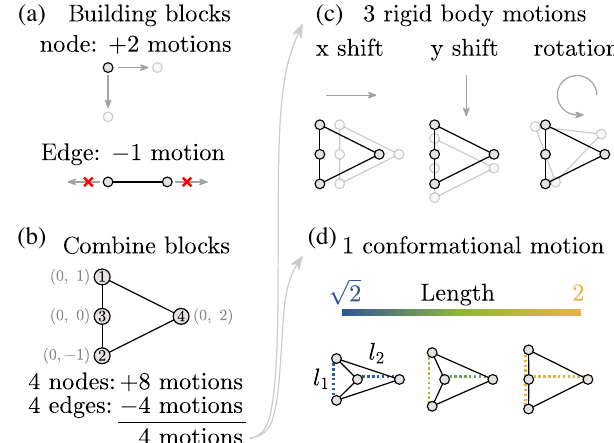
FIG. 1. Constraints and conformational motions. (a) Schematic of a node and an edge embedded in two dimensions, where a node adds two motions (one in each dimension), and an edge removes the one motion that changes its length. (b) Network of four nodes and four edges, yielding a total of four motions, (c) three of which are rigid body motions and (d) one of which is a conformational